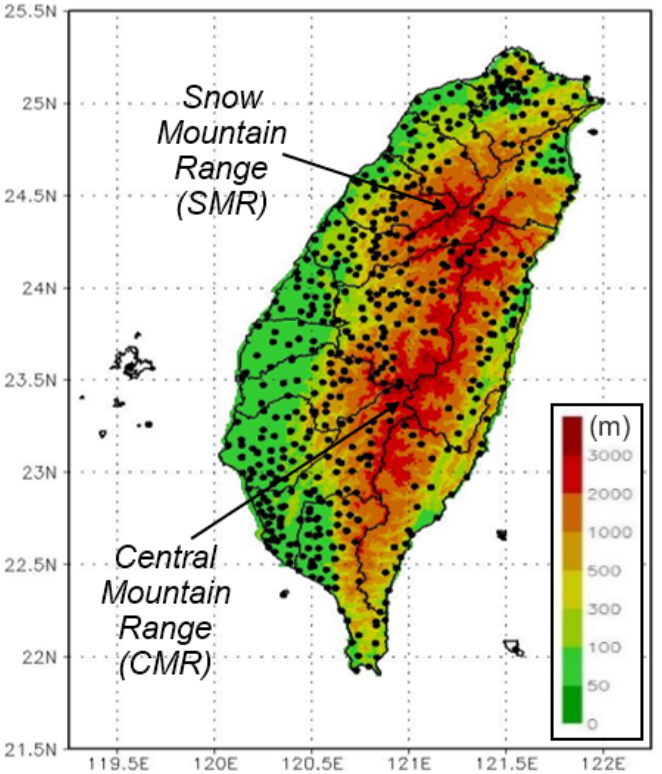
Figure 1. The topography of Taiwan (m, color) and distribution of rain gauges (dots). The Central Mountain Range (CMR) and Snow Mountain Range (SMR) of Taiwan are indicated.